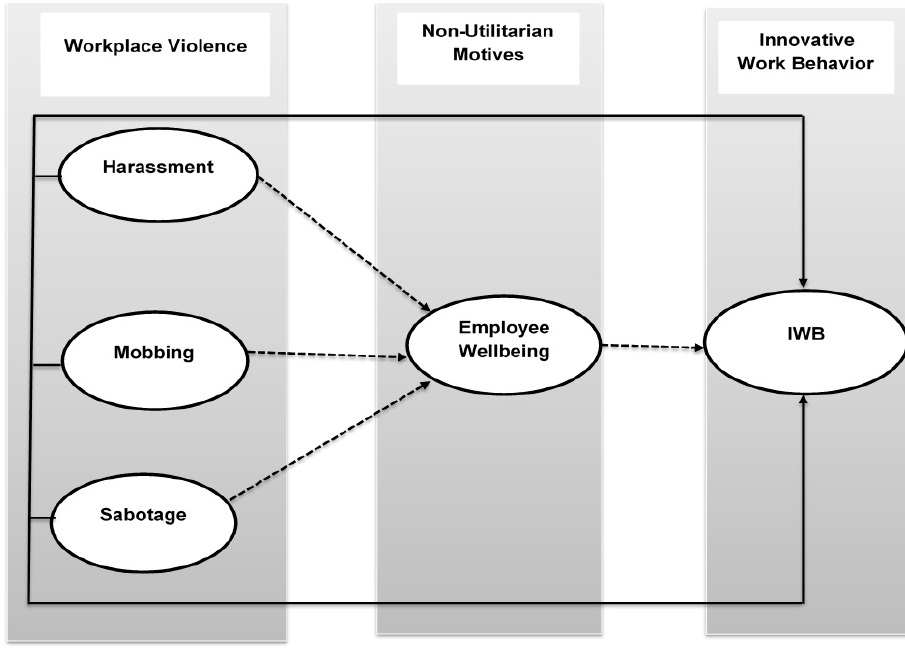
Figure 1. Proposed research model.